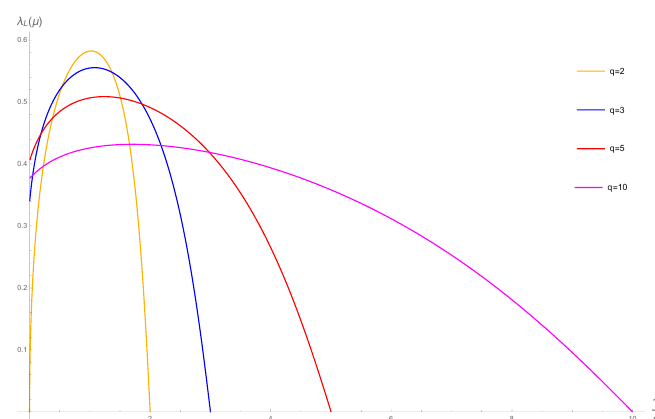
Figure 12. The Lyapunov exponent as a function of (cid:22) for the whole range of (cid:22) . We observe that near the (cid:22) ! + 1 limit only the model with q = 2 has a vanishing Lyapunov exponent. This is consistent with the fact that only at q = 2 the set of higher-spin operators have vanishing anomalous dimension and generate a higher-spin